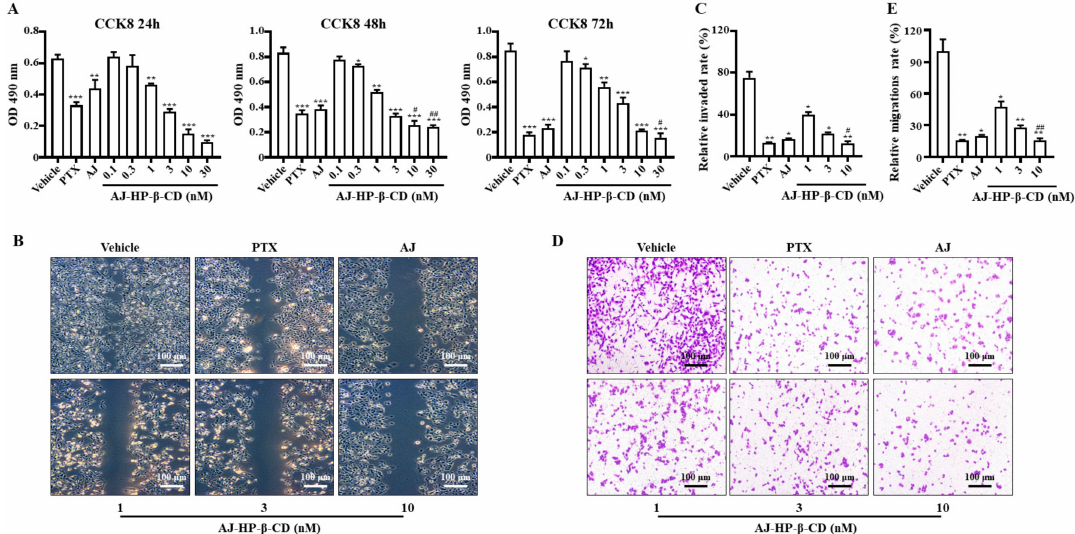
Figure 3. E ff ect of AJ-HP- β -CD on 786-O cell invasion and migration. ( A ): The cytotoxicity of AJ-HP- β -CD on 786-O cells with PTX (10 nM), AJ (10 nM), and AJ-HP- β -CD (0.3, 1, 3, 10, 30 nM) after 24, 48 and 72 h. ( B ), ( C ) Representative images scratch assay of 786-O cells with PTX (10 nM), AJ (10 nM), and AJ-HP- β -CD (1, 3, 10 nM) after 12 h. ( D , E ) Representative images of the transwell migration assay of 786-O cells with PTX (10 nM), AJ (10 nM), and AJ-HP- β -CD (1, 3, 10 nM) after 12 h. * p < 0.05, ** p < 0.01, *** p < 0.001 compared with vehicle ( n = 3), # p < 0.05, ## p < 0.01 compared to AJ, statistical analysis was calculated using Student’s t -test ( n =